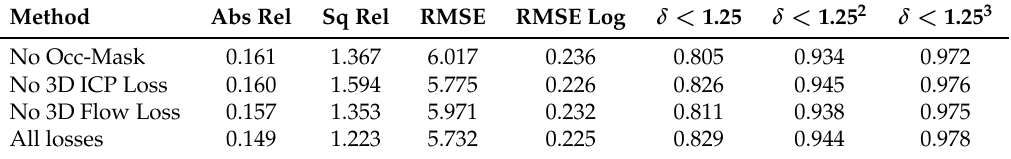
Figure 3. Comparison of monocular depth estimation between Eigen et al. [10] (supervised by depth), Garg et al. [21] (supervised by stereo), Zhou et al. [15] (unsupervised) and ours (unsupervised). Our method captures more details in the whole scene and particularly in thin structures for both close and distant regions. Table 4. Ablation results where individual components are left out on KITTI dataset when capped 80 m.